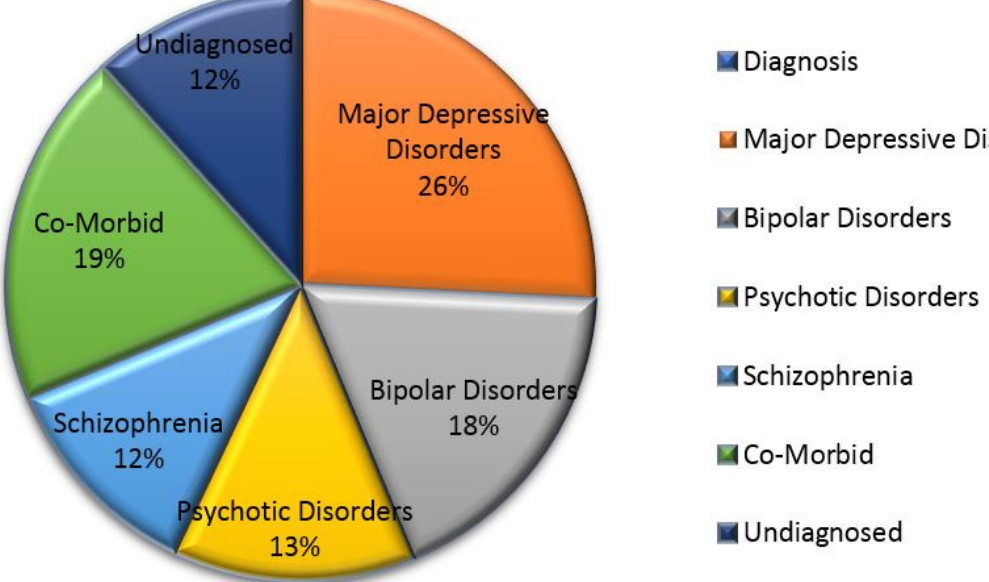
Figure 2. The percentage wise distribution of the underlying diagnosis of the patient with suicidality.